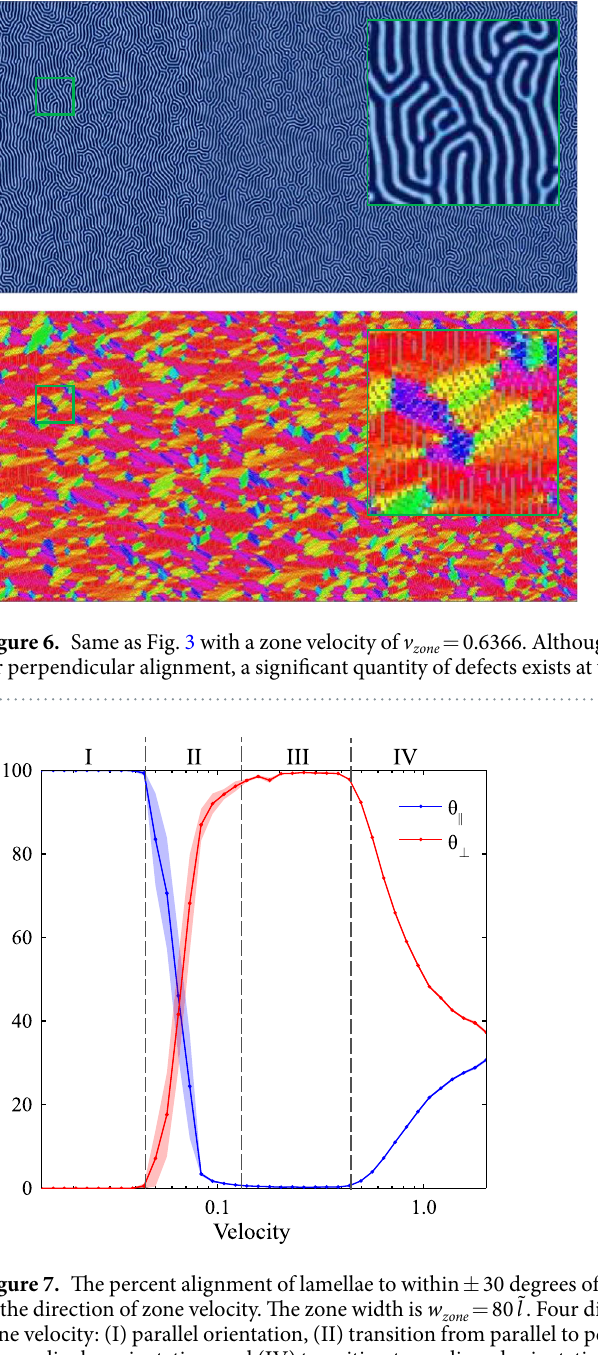
as Region III. For zone velocities in this region, it is only the far left boundary of the computational domain, where the temperature zone first enters the domain, that exhibits some variation in alignment (see Fig. 5). Near this boundary, which has neutral chemical preference, the BCP domains align either parallel or perpendicular to the boundary (Cong et al . 47 analyzed wall interactions to a greater extent). However, in a very short distance, the BCP alignment becomes uniformly perpendicular as can be seen in the orientation plot of Fig. 5. With further increases in the zone velocity, the system exhibits decreased global alignment, as shown in Region IV, where the percent perpendicular and percent parallel alignment curves both approach 33%, which corresponds to their portion of the 180 degree range. In this region, the thermal front of the zone moves across the sample rapidly, and the results converge to those associated with isothermal annealing, and therefore the zone annealing process becomes ineffective as a directed self-assembly method.